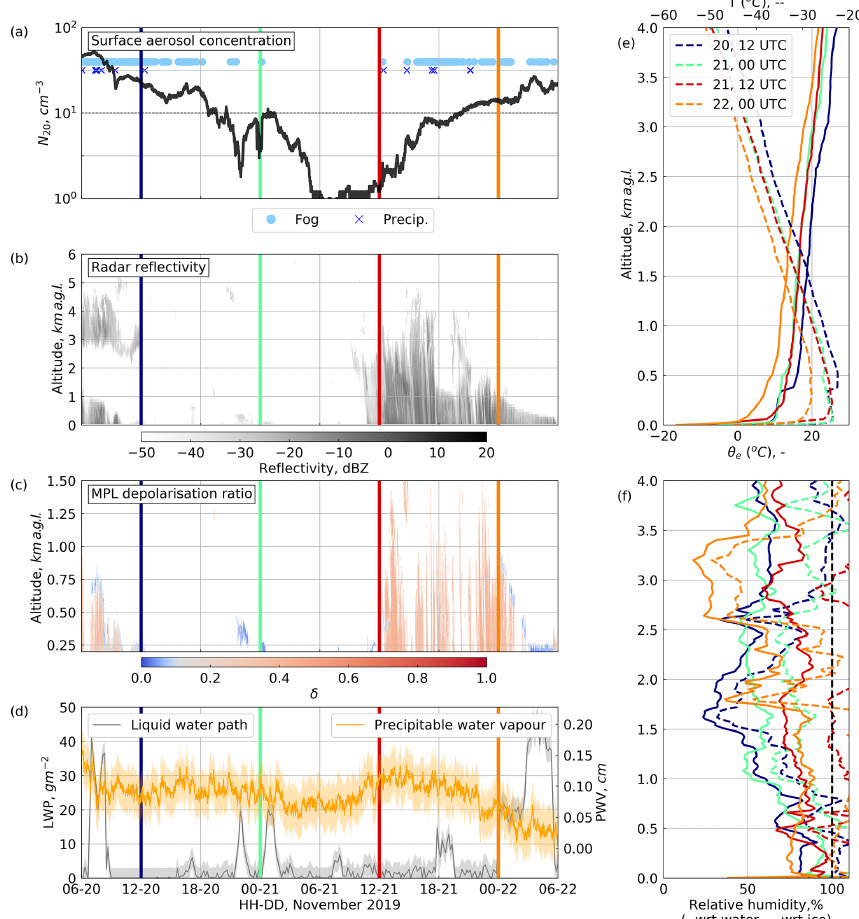
Figure 15. Same as Fig. 11 but during the 21 November 2019 low-aerosol case study. Note that there are no SBI events recorded during this period due to missing data but that the radiosonde profiles indicate a constant shallow surface-based temperature inversion throughout.